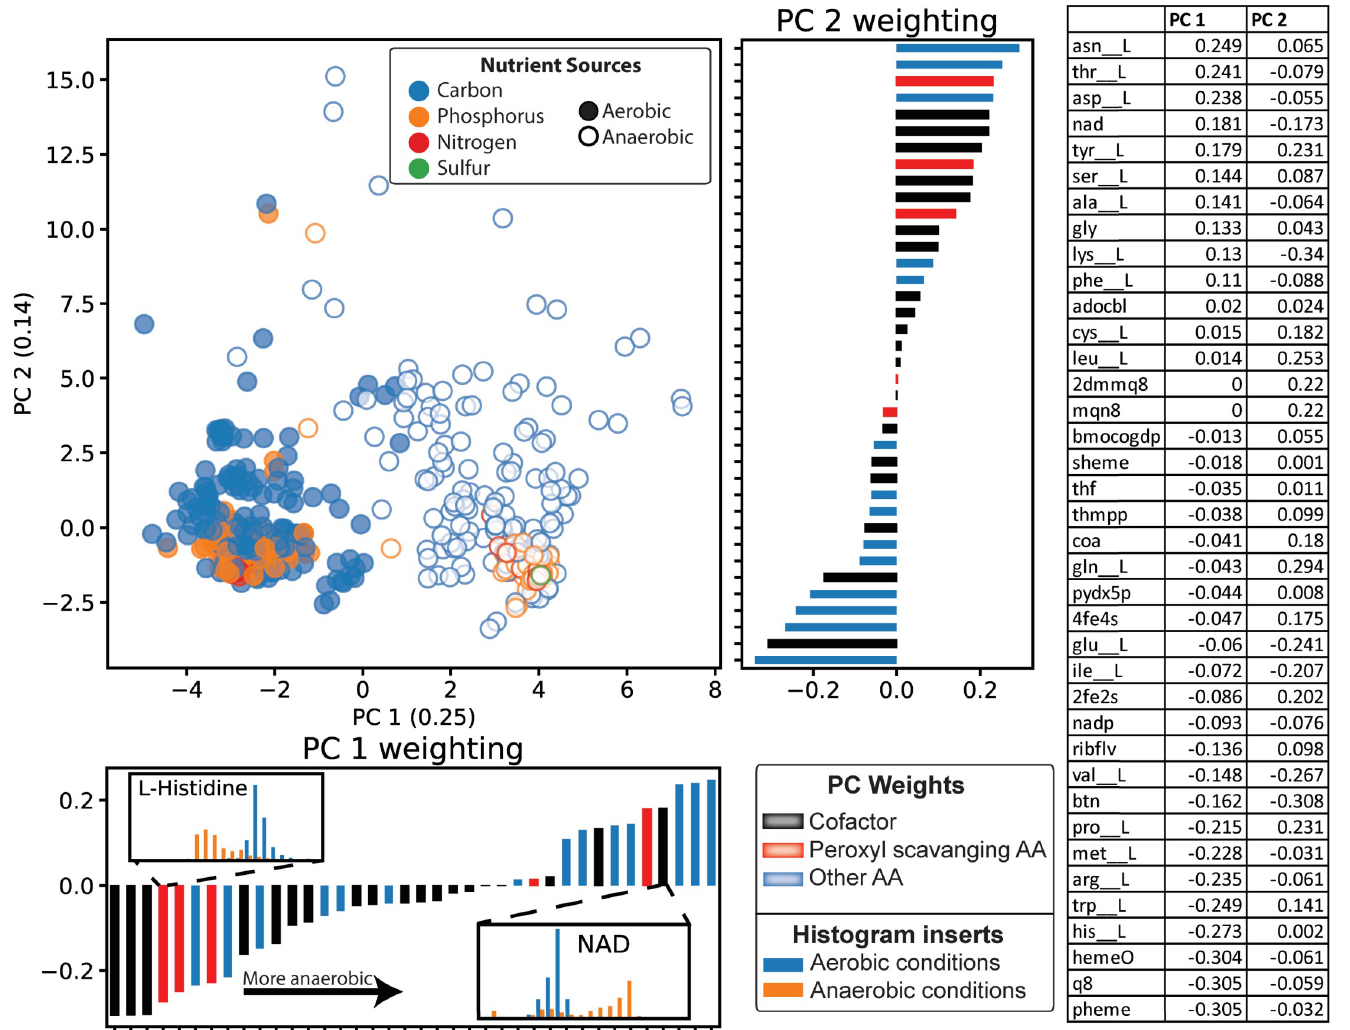
Fig 4. Differences in the synthesis demand of enzyme cofactors and amino acids by aerobicity. PCA analysis of all computed growth conditions reveals aerobic (filled points) and anaerobic (outlined points) growth conditions can be resolved by principal component 1. The protein biomass normalized micronutrient demand for L-histidine and NAD are shown next to their component 1 weighting. The two histograms demonstrate the clear separation in aerobicity-dependent demand of these micronutrients. A table of the principal component vector weightings is shown on the right.